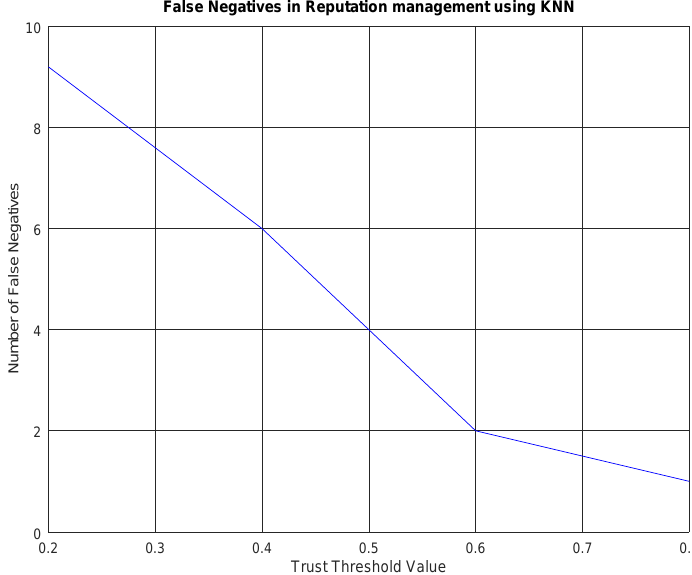
Figure 11. False negatives in reputation management using